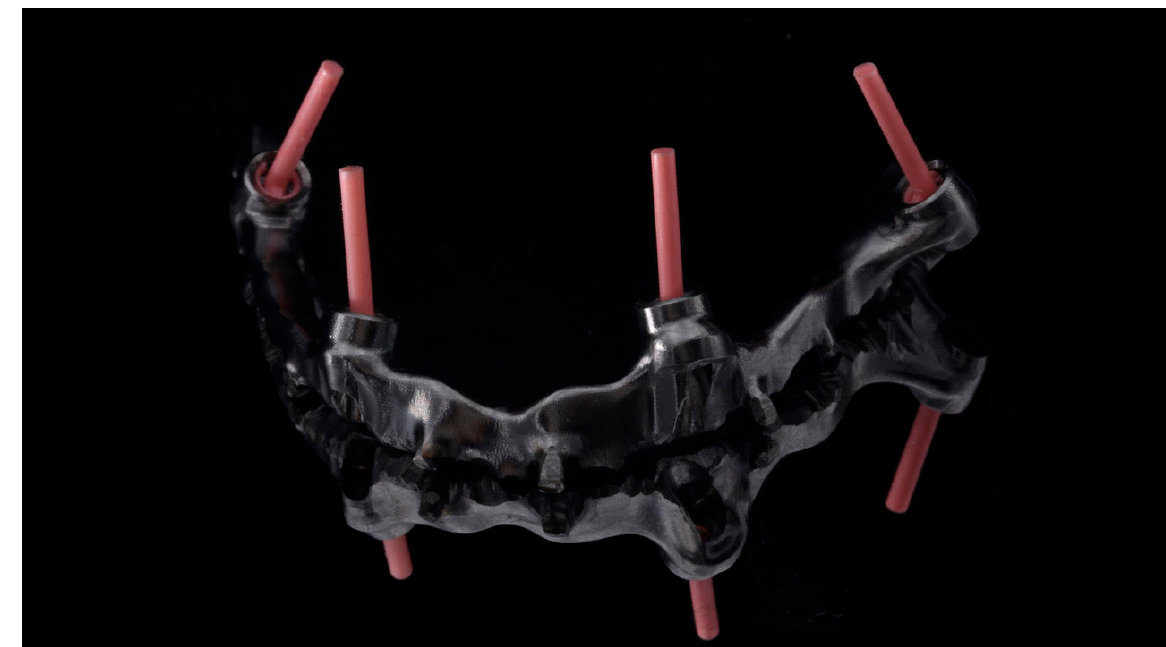
Figure 10. CAD project with Extragrade abutments for milled titanium reinforcement.